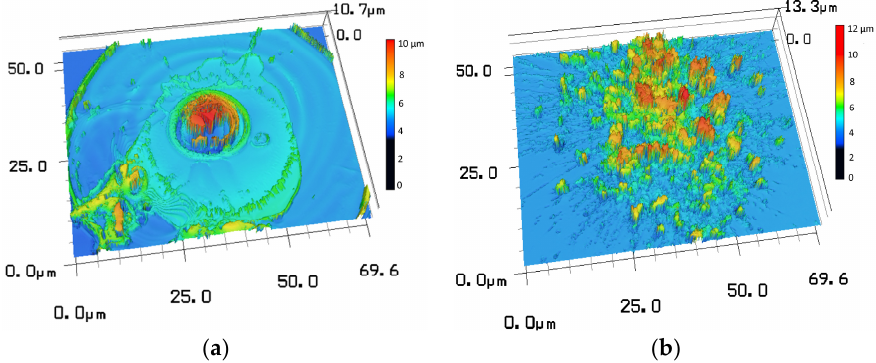
Figure 3. 3D ‐ surface morphology of HVOF ‐ sprayed ( a ) molten ( φ = 1.01) and ( b ) non ‐ molten ( φ = 0.96) Yb 2 Si 2 O 7 single splats on Si wafer. The images were produced using a confocal laser microscope.